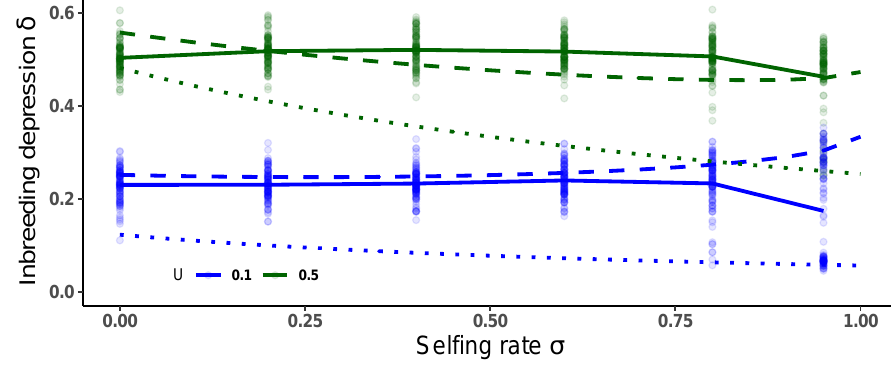
Figure S10 – POD zones increase inbreeding depression. Inbreeding depression, δ , as a function of the selfing rate for populations with higher ( U = 0.5) and lower ( U = 0.1) haploid genomic mutation rates. Solid lines represent means of the simulations run with a POD zone while dotted lines show the δ expected in the absense of overdominance (Eq. (7)). Dashed lines show the δ expected with overdominant selection (Eq. (6)). Other 6 parameter values are n L = 100 and ℓ = 10 − Morgans. Mutations are randomly placed within the POD zone. Selection coefficients within and outside the POD zone, s and s d respectively are set to 0.01 , and dominances h and h d = 0.2 . The genome size setting the recombination rate is R = 1